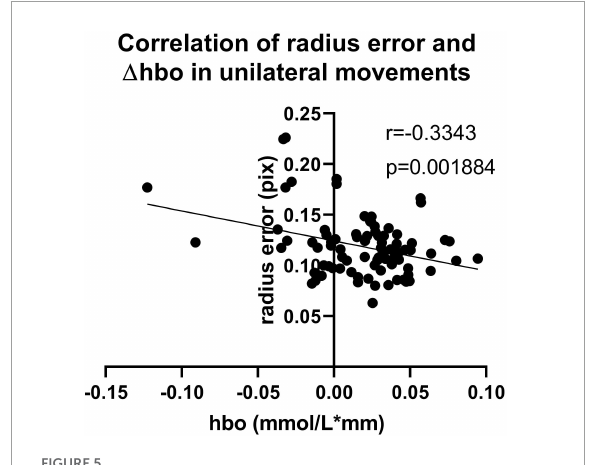
FIGURE5 Correlation of radius error and (cid:49) hbo (corr = –0.335, p = 0.002) in unilateral movements.